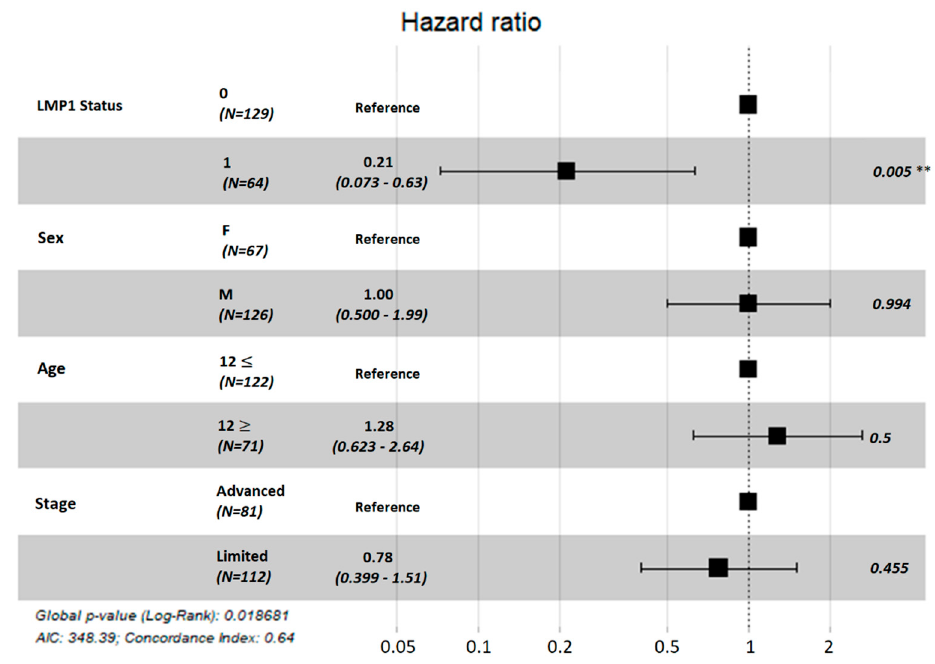
Figure 2. Multivariate analysis of the effect of EBV positivity on event-free survival in 166 cHL patients, adjusting for sex, age, and stage. ** marks p-values less than 0.01.